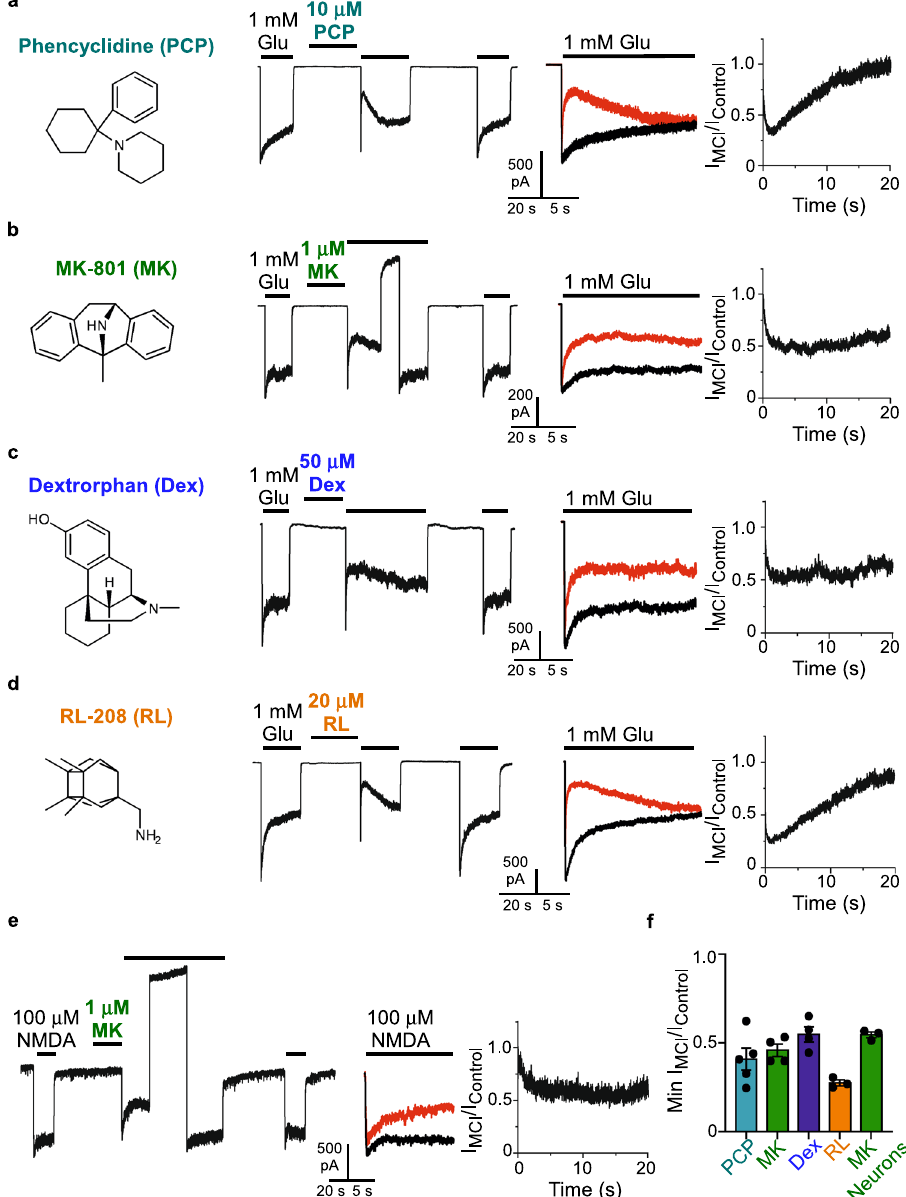
Fig. 3 Multiple NMDAR channel blockers exhibit MCI. a – d Chemical structures of uncharged forms of additional NMDAR channel blockers examined (left); examples of current traces during MCI protocols performed at pH 7.2 using GluN1/2A receptor-expressing tsA201 cells; overlays of I Control and I MCI (I MCI in red); I MCI /I Control point-by-point ratios (right). Concentrations and blockers tested: 10 μ M phencyclidine (PCP; a ); 1 μ M MK-801 ( b ), 50 μ M dextrorphan (Dex; c ), 20 μ M RL-208 ( d ). e Examples of current trace during MCI protocol performed with 1 μ M MK-801 at pH 7.2 using neurons in primary culture, overlay of I Control and I MCI (I MCI in red), and I MCI /I Control point-by-point ratio (right). 50 μ M APV was applied from 1 s before until 0.2 s after MK- 801 application to ensure that channel openings during MK-801 application (which could allow traditional channel block) did not occur. All solutions used for neuronal recordings contained 1 μ M tetrodotoxin and 1 μ M Ro 25-6981; NMDARs were activated by application of 100 μ M NMDA. In b and e a 20 s to 30 s V m step to 30 mV was performed after MK-801 application to speed unbinding from the deep site, allowing full recovery from MK-801 inhibition (needed because MK-801 has a much slower unbinding rate at − 65 mV than the other blockers). f Min I MCI /I Control based on the protocols shown in a – e for 10 μ M PCP (0.409 ± 0.063, n = 5), 1 μ M MK-801 (0.459 ± 0.035, n = 4), 50 μ M dextrorphan (0.549 ± 0.043, n = 4), and 20 μ M RL-208 (0.275 ± 0.017, n = 3) applied to tsA201 cells, and 1 μ M MK-801 (0.612 ± 0.019, n = 3) applied to cultured neurons. Min I MCI /I Control values were compared to 1 with two-sided t-test; all are signi fi cantly different from 1 (PCP, t = − 9.36, df = 4, p = 0.00073; MK-801 with GluN1/2A receptors, t = − 15.5, df = 3, p = 0.00059; Dex, t = − 10.5, df = 3, p = 0.0019; RL-208, t = − 43.4, df = 2, p = 0.00053; MK-801 with neurons, t = − 28.3, df = 2, p = 0.0013). Mean± SEM is